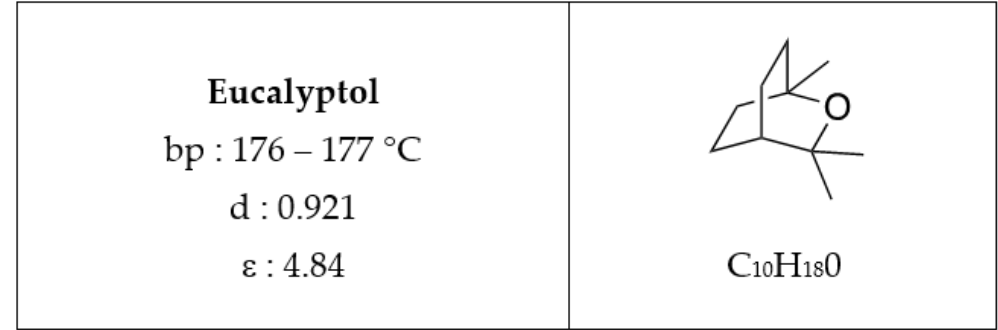
Figure 2. 1,8-cineole structure and properties .